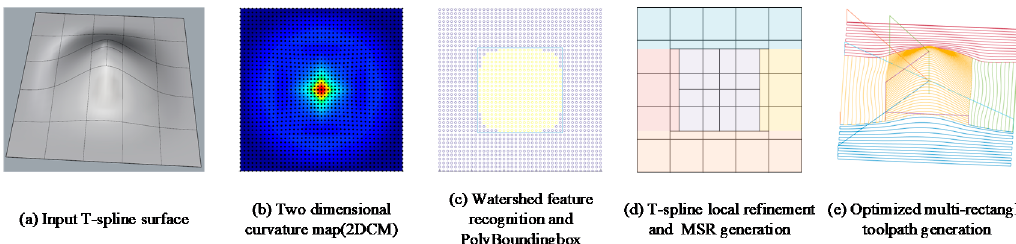
Figure 2. Flow chart of watershed-based toolpath generation for the T-spline surface: ( a ) the input T-spline surface that has one convex feature, ( b ) two-dimensional curvature map shaded by root-mean-square curvature, ( c ) watershed results and PolyBoundingBox construction for the convex feature, ( d ) MSRs generation using T-spline local refinement, and sub-regions are shaded using different color, ( e ) optimized multi-rectangle toolpath generation for the surface.